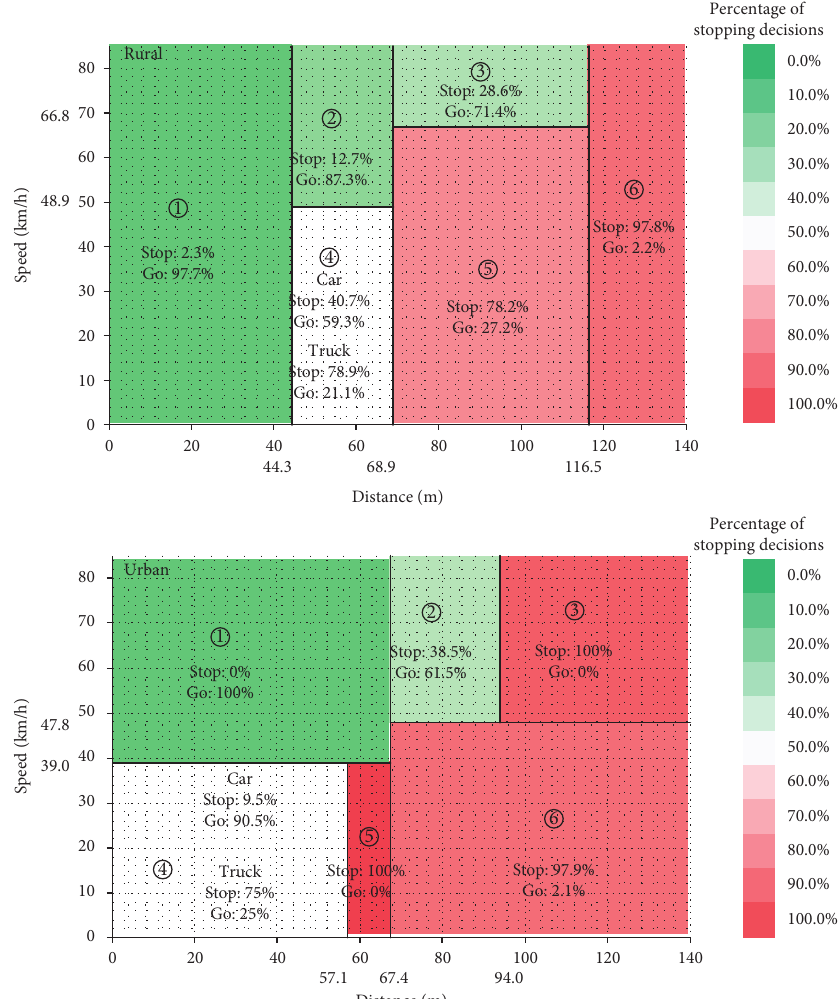
Figure 8: Comparison of the stop/go decision between rural and urban